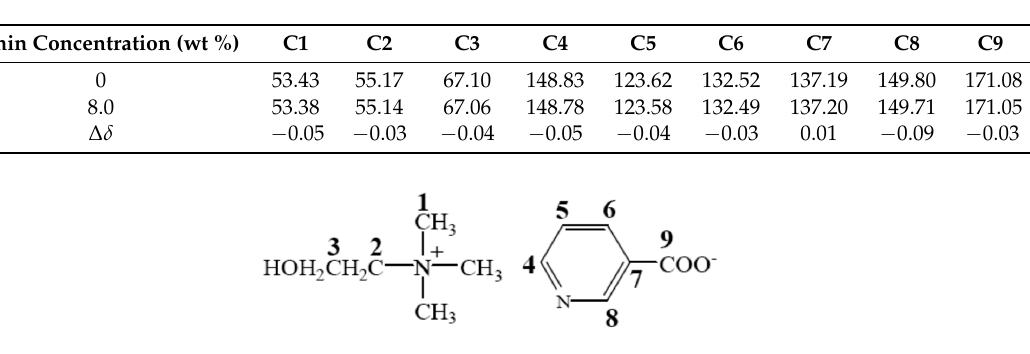
Figure 1. The schematic structure and carbon atom numbering of [Ch][Na].